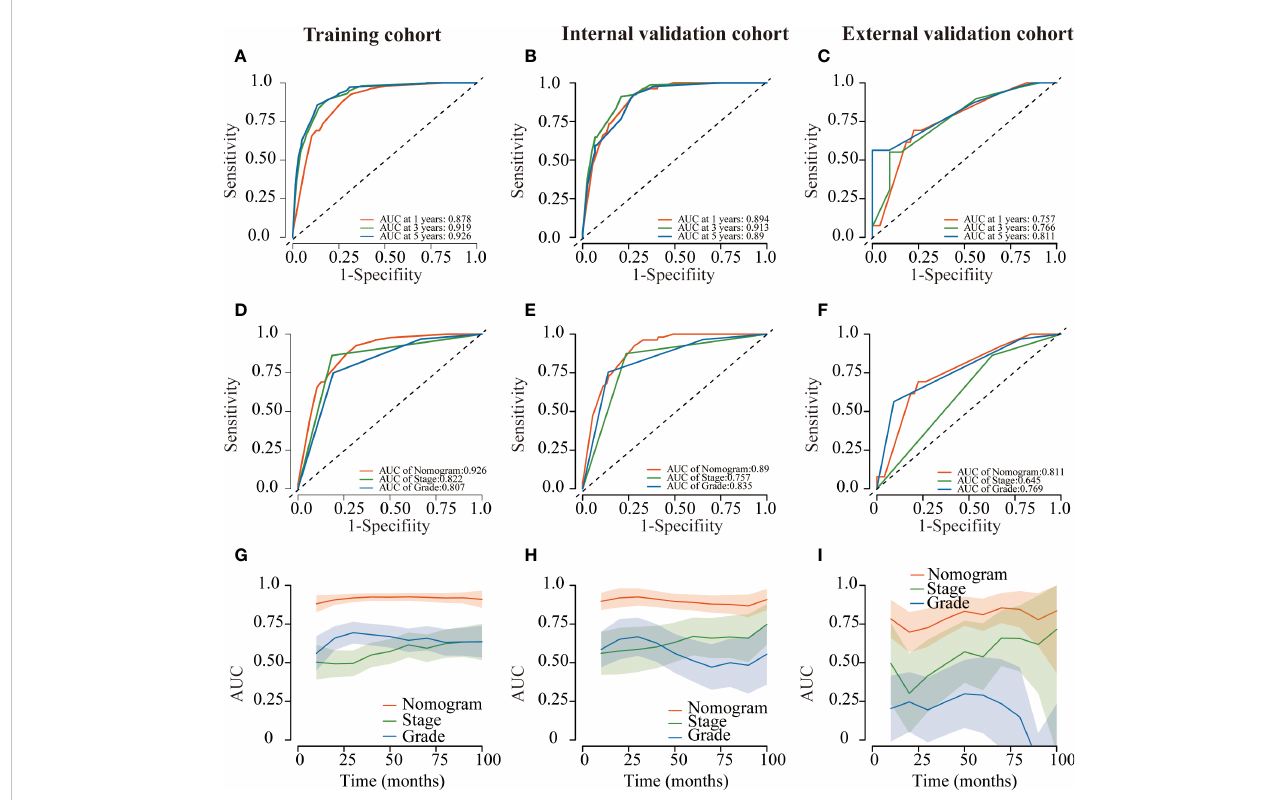
FIGURE 8 ROC curves of the nomogram of CRNENs for 1, 3, and 5-year DSS rates in the training cohort (A) , the internal validation cohort (B) , and the external validation cohort (C) . Variable-dependent ROC curves of CRNENs of 5-year DSS in the training cohort (D) , the internal validation cohort (E) , and the external validation cohort (F) . Time-dependent AUC curves for the nomogram of DSS in the training cohort (G) , the internal validation cohort (H) , and the external validation cohort (I) . CRNENs, colorectal neuroendocrine neoplasms; DSS, disease-speci fi c survival; ROC, receiver operating characteristic; AUC, area under the